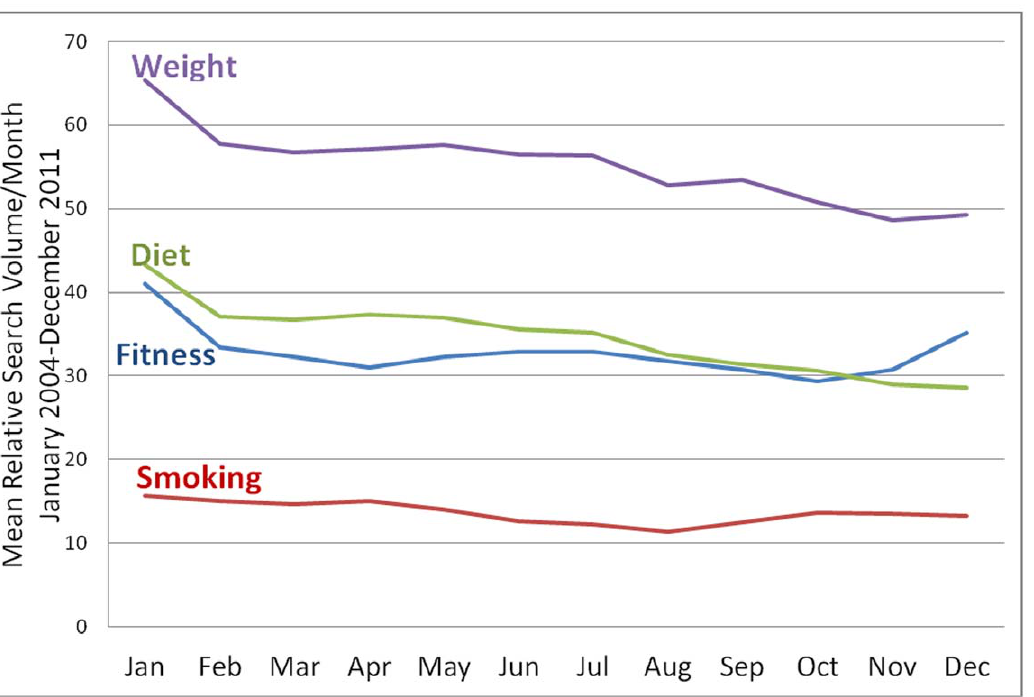
Figure 1. Mean relative search volume per month from 2004 to 2011for terms ‘weight, ‘diet’, ‘fitness’ and ‘smoking’.